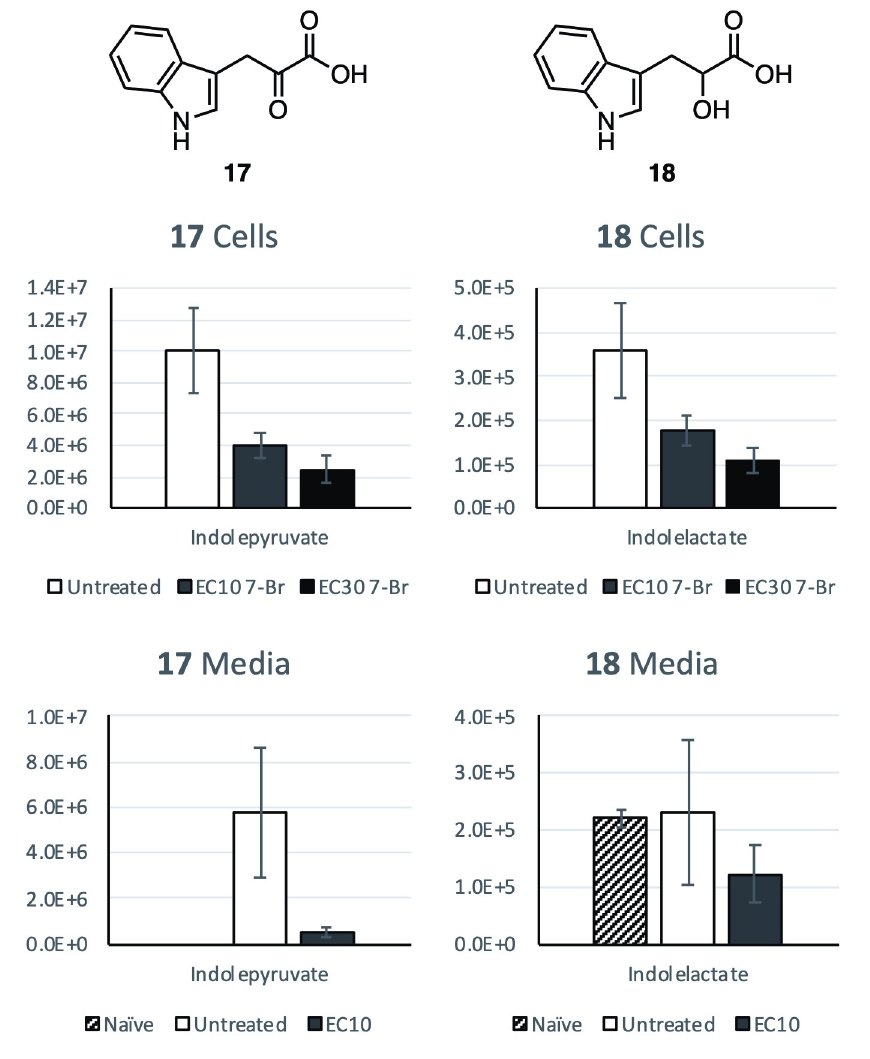
Fig 4. The effect of 7-Br tryptophan methyl ester (13) treatment on the relative medium and cellular levels of selected metabolites indolepyruvate (17) and indole lactate (18). Relative levels are detected ion counts by MS from separate samples. Error bars show SD calculated from n = 3